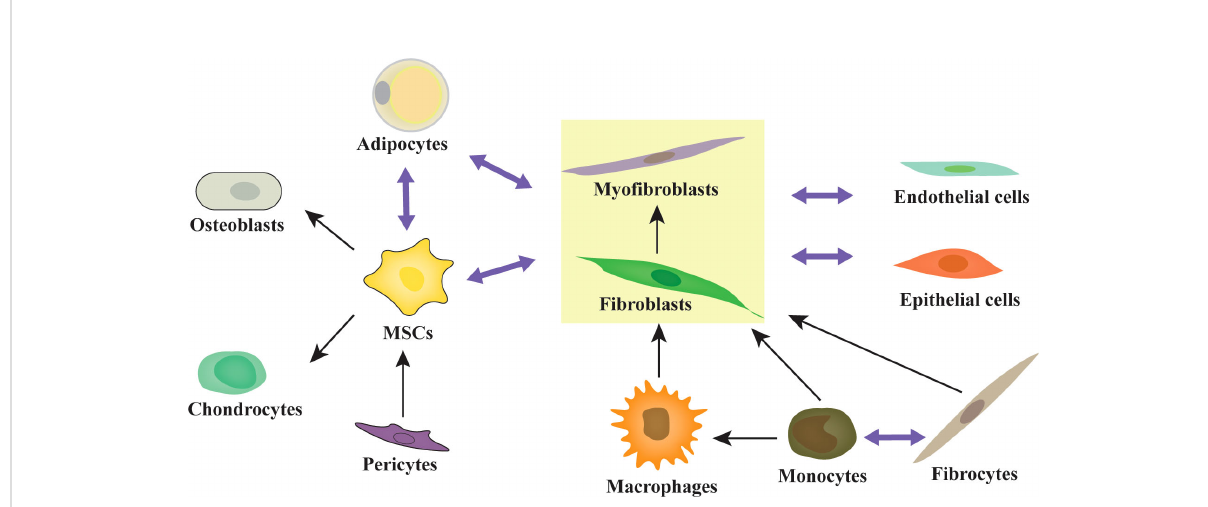
FIGURE 2 The multipotent differentiation capacity of origin cells of CAFs. Activated fi broblasts, MSCs, and adipocytes are highly plastic and exhibit multipotent capacity. MSCs can differentiate into osteoblasts, chondrocytes, adipocytes, and fi broblasts/myo fi broblasts. Adipocytes can differentiate into fi broblasts/myo fi broblasts and osteoblasts. Fibrocytes can differentiate into monocytes, fi broblasts/myo fi broblasts, adipocytes, osteoblasts, and chondrocytes. Monocytes can differentiate into fi brocytes, macrophages, and fi broblasts/myo fi broblasts. The pericytes and adipocytes can differentiate into MSCs. Similarly, activated fi broblasts can transform into MSCs, adipocytes, chondrocytes, endothelial cells, ECs, and